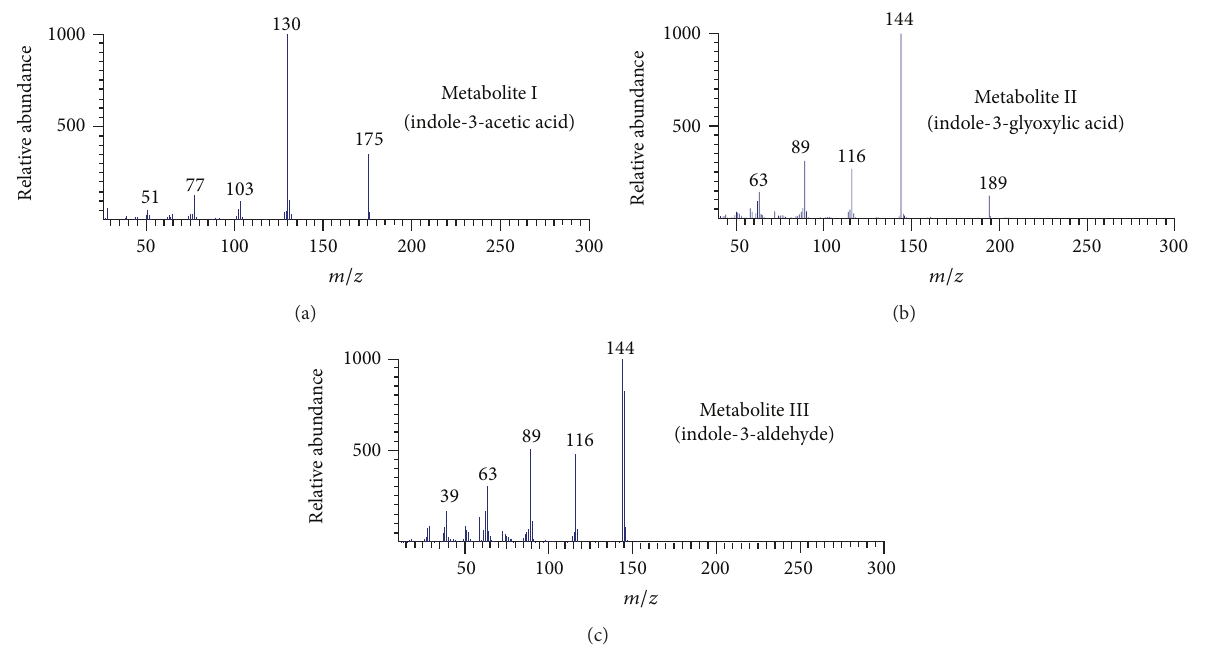
Figure 3: GC-MS analysis showing mass spectrum of metabolite I (indole-3-acetic acid, (a)), metabolite II (indole-3-glyoxylic acid, (b)), and metabolite III (indole-3-aldehyde,